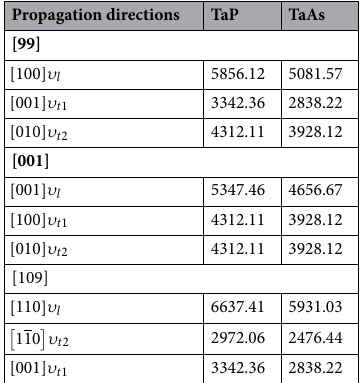
Table 7. Anisotropic sound velocities (ms −1 ) of TaP and TaAs along different crystallographic